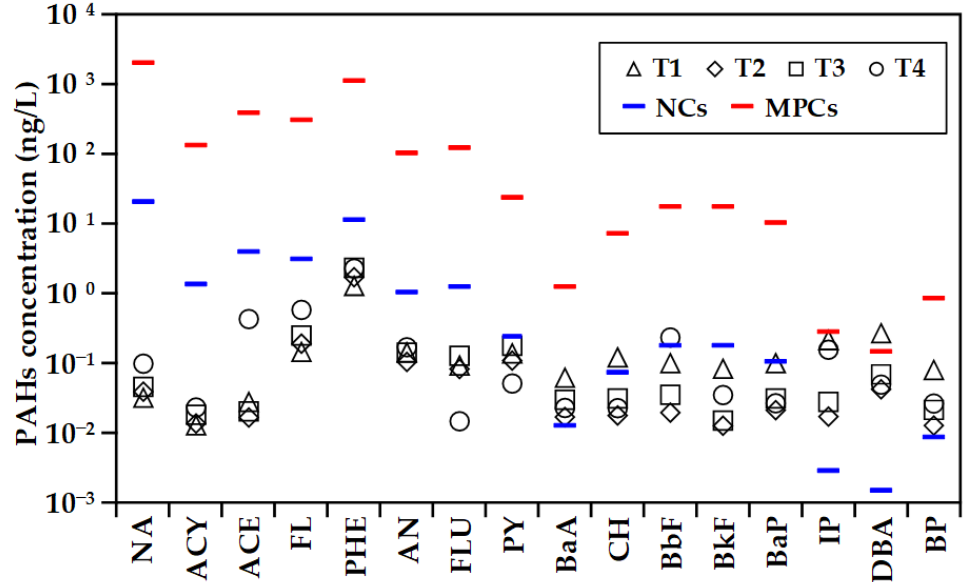
Figure 3. Comparison of PAHs measured in seawater with NCs (negligible concentrations) and MPCs (maximum permissible concentrations). Table 5. Comparing the concentrations of dissolved PAHs in surface seawater reported in different regions of the